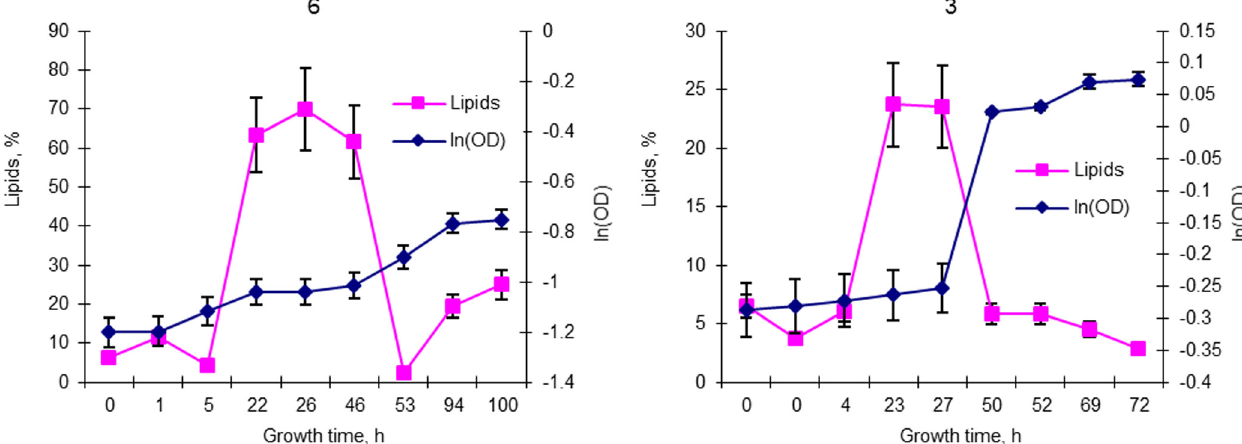
Fig. 3. Monitoring of lipid content in and biomass density in two representative experiments, aimed to de fi ne the best combination of growth cycle time and reactor conditions[16].